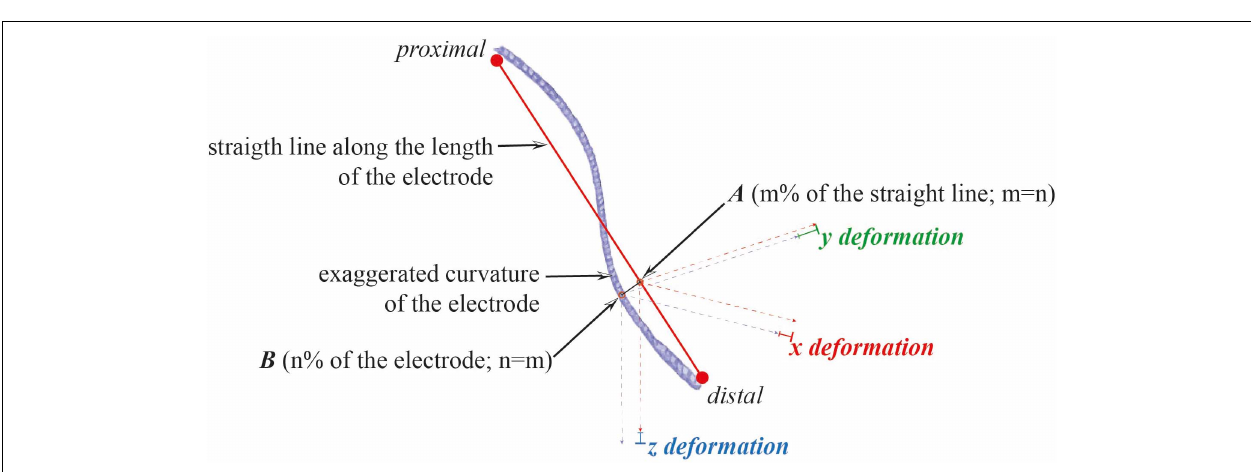
FIGURE 8 | Deformation of electrodes. The deformation of each electrode was computed in the x, y, and z directions by calculation of the distance between the skeleton of the electrode and the straight line along its length, normalized to 100